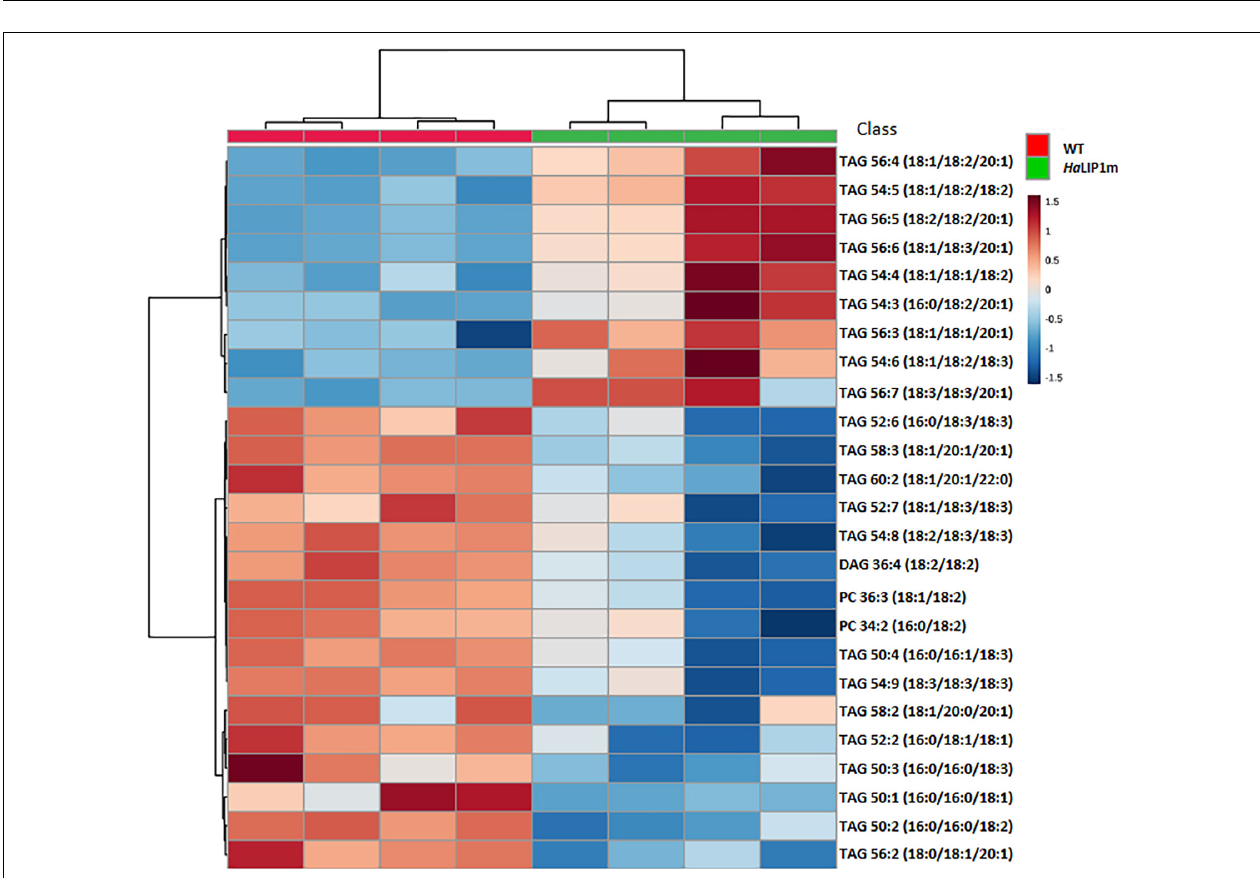
FIGURE 10 | Hierarchical clustering and heatmap of the most significantly different lipid species (right) comparing mature control (WT, in red) and transgenic HaLIP1m seeds (blue). TOP 25 p < 0.05 t -test.